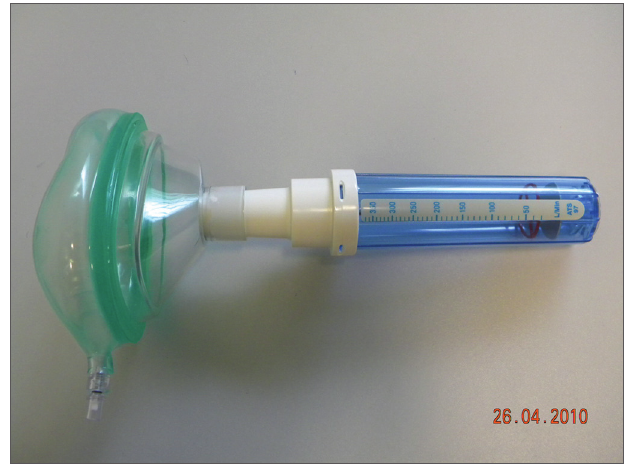
Figure 1. Nasal Inspiratory Peak Flow (NIPF).